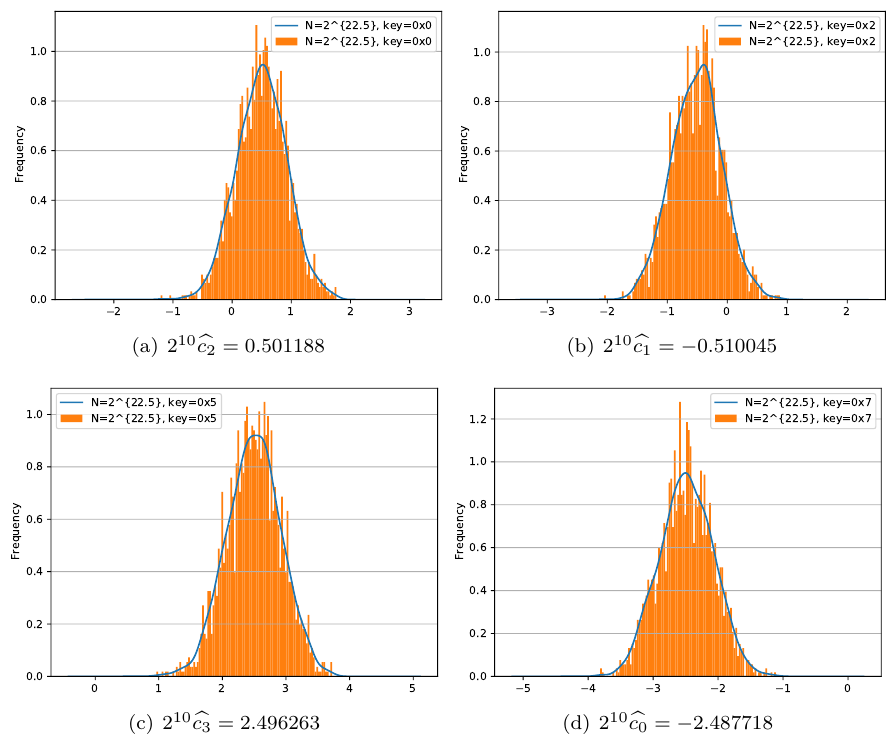
Figure 11: Experimental verification of the assumption adopted in our search algorithm. Here, we only present the case when N = 2 22 . 5 for an